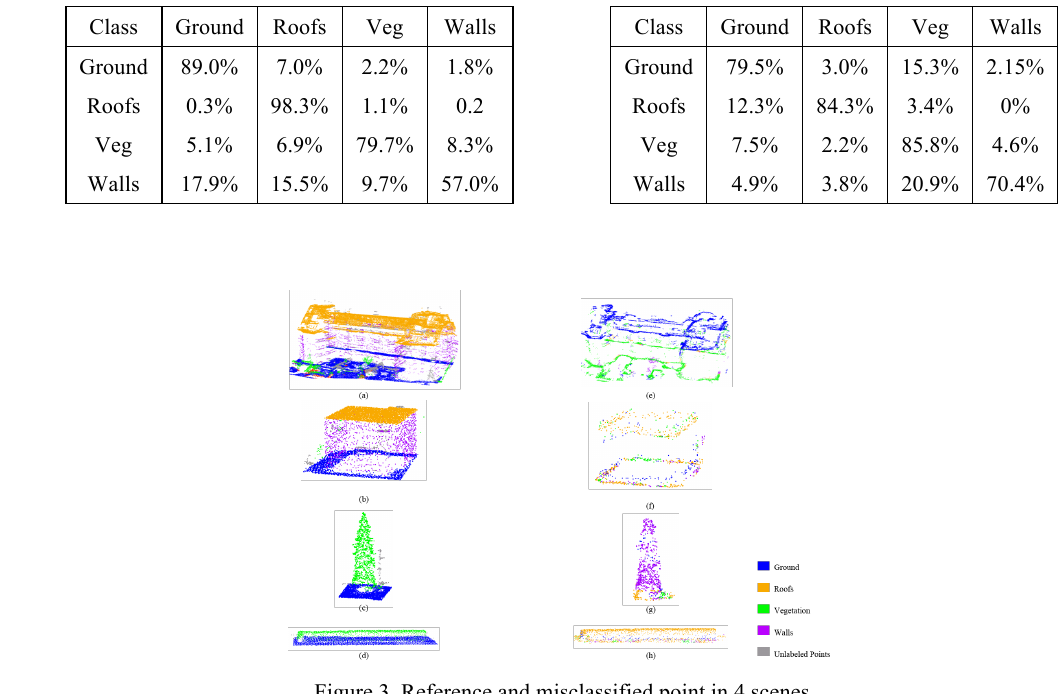
Table 1. Dataset1 Classification confusion matrix Table 2. Dataset2 Classification confusion matrix